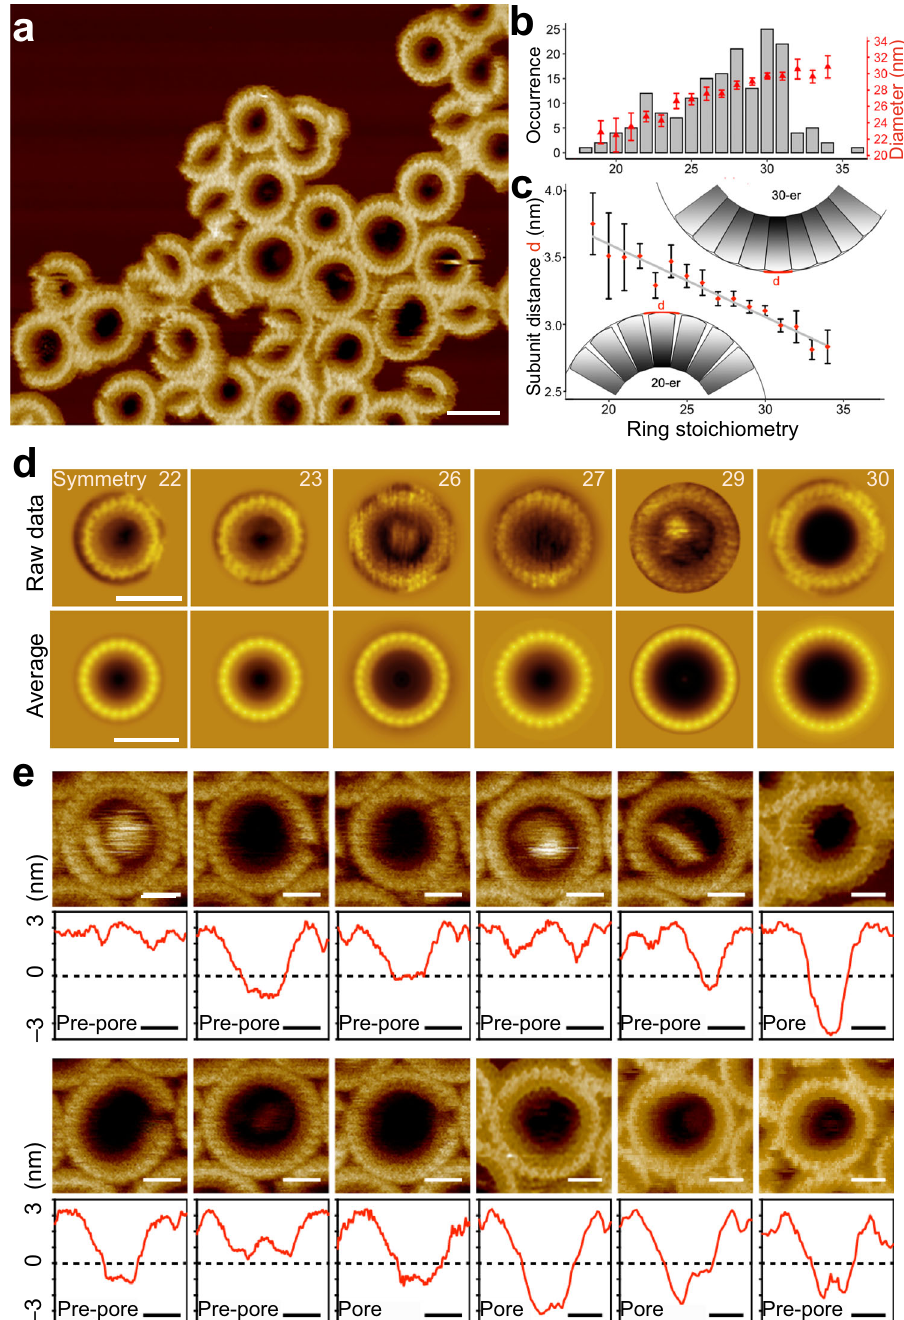
Fig. 4 mGSDMA3 Nterm features high structural fl exibility to assemble ring-shaped oligomers of different stoichiometries that show different stages of pore formation. a High-resolution FD-based AFM topograph of mGSDMA3 Nterm oligomers inserted in SLMs made from E. coli polar lipid extract. Visible are individual mGSDMA3 Nterm assembling variably sized and shaped oligomers. b Left axis, occurrence of ring-shaped mGSDMA3 Nterm oligomers ( n = 174) showing symmetries ranging from 18 to 36. The most prominent stoichiometry observed is 30, followed by 31, 28, 27, 26 and 29. Right axis, outer diameter of ring-shaped mGSDMA3 Nterm oligomers having different stoichiometries. c Distance between mGSDMA3 Nterm at the outer periphery of ring-shaped oligomers having different stoichiometries. Distances were estimated from the outer diameter of ring-shaped oligomers ( b ) divided by the number of mGSDMA3 Nterm . Data points (red) in ( b , c ) give averages and errors SE of 174 ring-shaped mGSDMA3 Nterm oligomers analyzed. Insets show a hypothetical packing of mGSDMA3 Nterm arranged into ring-shaped oligomers having 20 and 30 stoichiometries. d Correlation averaged AFM topographs. Top row, selected high-resolution contact mode and FD-based AFM topographs of individual ring-shaped mGSDMA3 Nterm oligomers inserted into SLMs and having different stoichiometries ranging from 22 to 30. Bottom row, symmetrized correlation averages of the exempli fi ed AFM topographs showing stoichiometries ranging from 22 to 30 (Methods). e High-resolution contact mode and FD-based AFM topographs and height pro fi les of individual ring- shaped mGSDMA3 Nterm oligomers inserted in lipid membranes. Oligomers residing in the pre-pore and pore state protrude at same height above the lipid membrane (see Fig. 1). Red lines indicate height pro fi les, black dashed lines indicate the SLM surface (0 nm height). The full-range color scale of the topographs corresponds to a vertical scale of 8 nm ( a ) and 6 nm ( d , e ). Scale bars, 30 nm ( a ), 20 nm ( d ), and 10 nm ( e